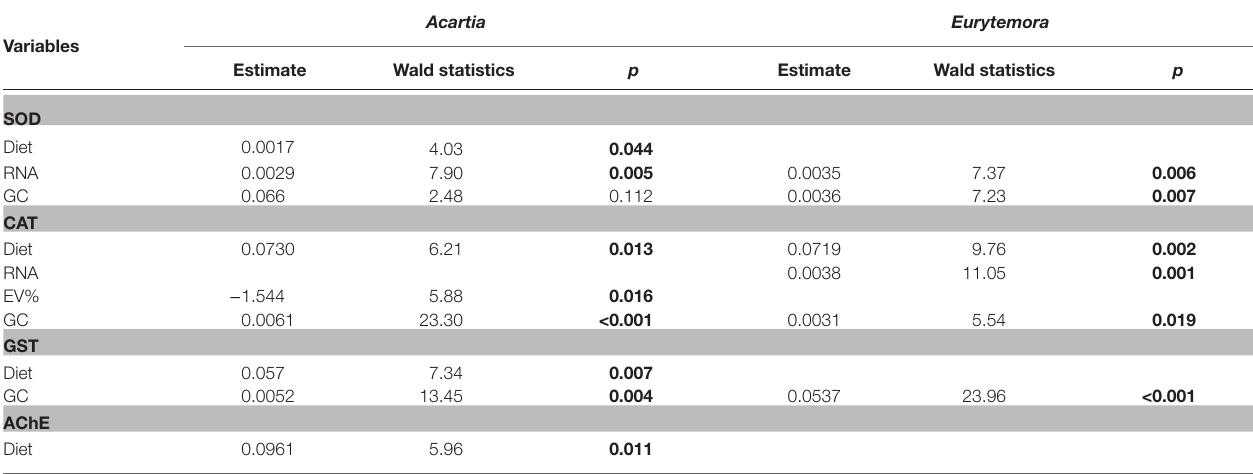
TABLE 3 | Best-fit GLZ models for relationships between enzyme activities (AChE, SOD; CAT and GST) as response variables and diet ( Nodularia/Rhodomonas vs. Rhodomonas ) as the categorical independent factor and individual RNA content (RNA), egg production (EP), egg viability (EV%), and gut content (GC) as possible continuous predictors in Acartia bifilosa and Eurytemora affinis